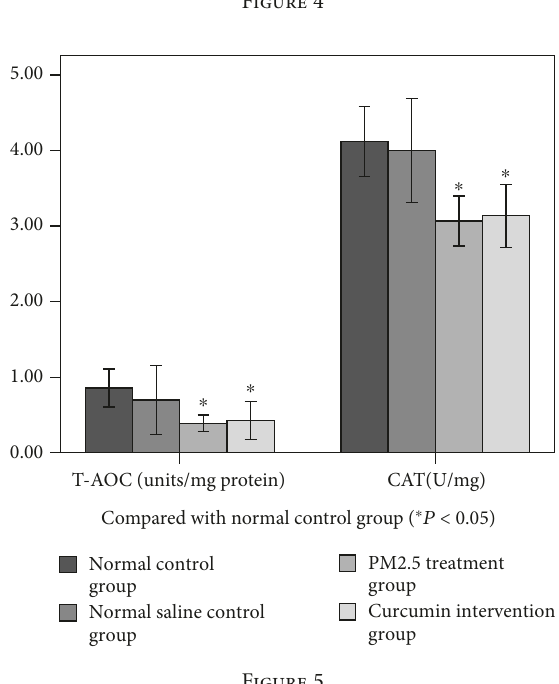
Compared with normal control group ( ⁎ P < 0.05)